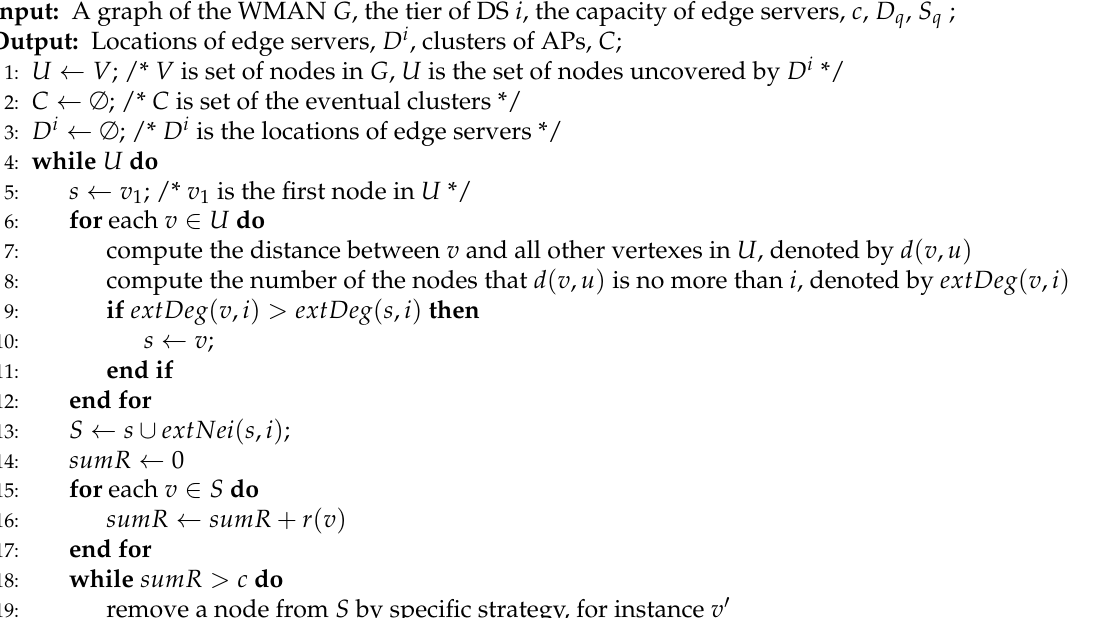
Algorithm 3 Greedy-based minimum extended dominating set algorithm with capacity